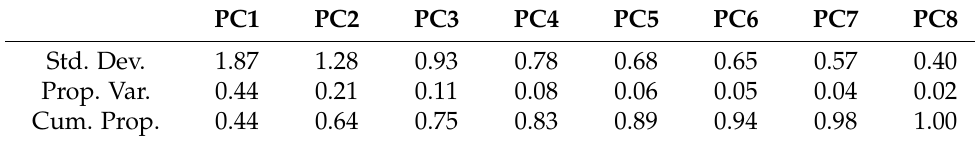
Table 8 lists the PCA summary for the prostate cancer data. Table 8. % variation explained by each components for the prostate cancer data.